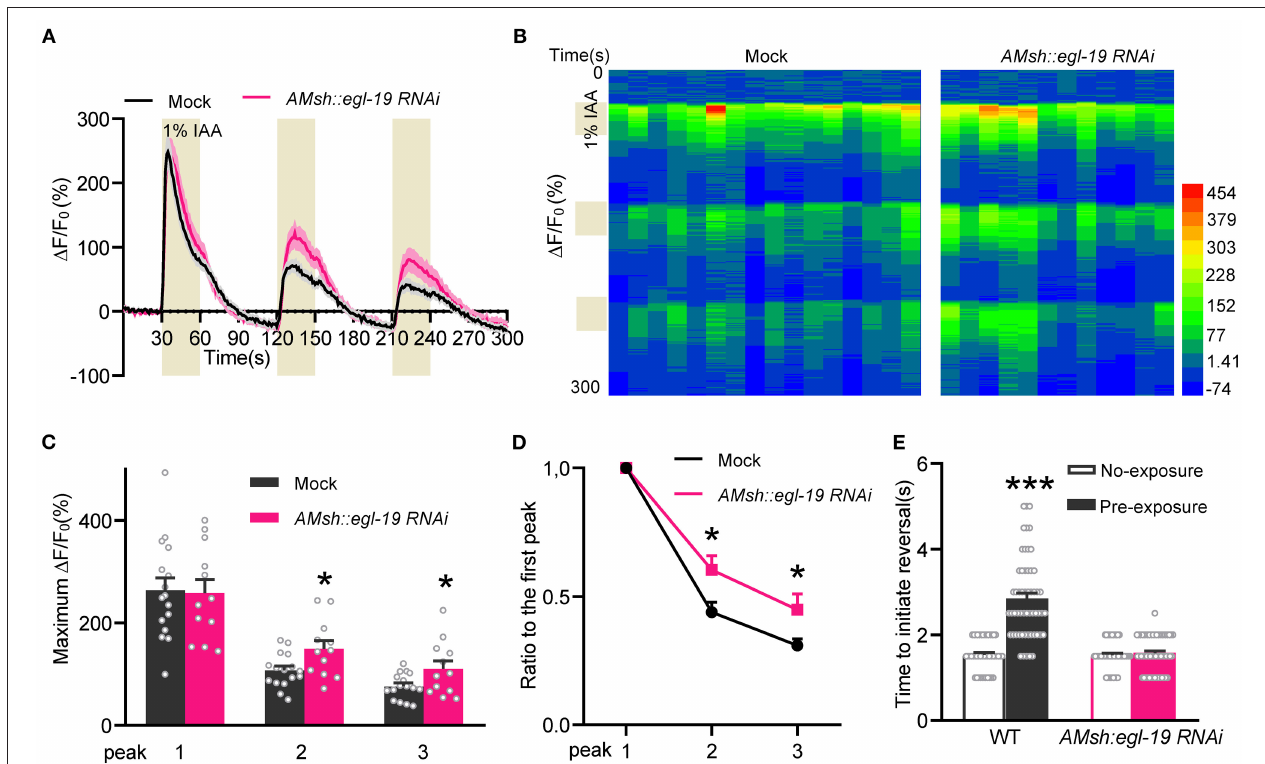
FIGURE 4 | EGL-19 acts on AMsh glia to modulate olfactory adaptation. (A–D) The calcium response adaptation of ASH neurons upon repetitive IAA stimulation (1:100 IAA, 30 s-odorant pulses with 1-min intervals) was reduced in worms with AMsh glia-specific knockdown of egl-19. (A) Calcium responses. (B) Heat map. (C) Maximum 1 F/F 0 changes of the ASH neuron in response to repetitive IAA. (D) The ratio of the average maximum 1 F/F 0 changes of peak 2 and peak 3 to the maximum 1 F/F 0 changes of the first peak. Mock (ST2996), n = 16; AMsh egl-19 RNAi (ST2995), n = 12; unpaired t -test. (E) Worms with AMsh glia-specific egl-19 RNAi shown reduced behavioral adaptation to IAA. Five milliliter of undiluted odorant was dropped on the lid of a 3 cm-diameter NGM plate, then D1 adult worms were transferred into the plate and were covered by the odorant-containing lid. Sealed the plate with Parafilm. After 5-min adaptation, worms were washed twice with basal buffer (5mM KPO 4 [pH 6], 1mM CaCl 2 , 1mM MgSO 4 ), and then were transferred onto normal NGM plates. Placed a 10 µ L pipette tip filled with IAA in front of a forward-moving worm, and recorded the response latency for the worm to cease forward movement and initiate reversal (backward movement). No-exposure [Mock (ST2996), n = 46; AMsh egl-19RNAi (ST2995), n = 46]; pre-exposure [Mock (ST2996), n = 56; AMsh egl-19RNAi (ST2995), n = 57]; unpaired t -test. Error bars represent SEM. * p < 0.05; *** p <